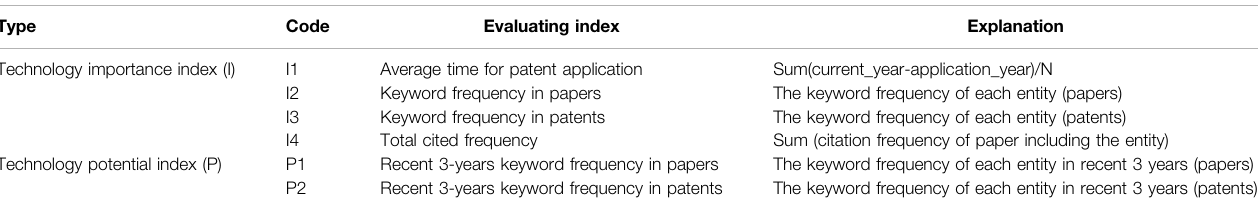
TABLE 1 | Indexing system to evaluate the utility of